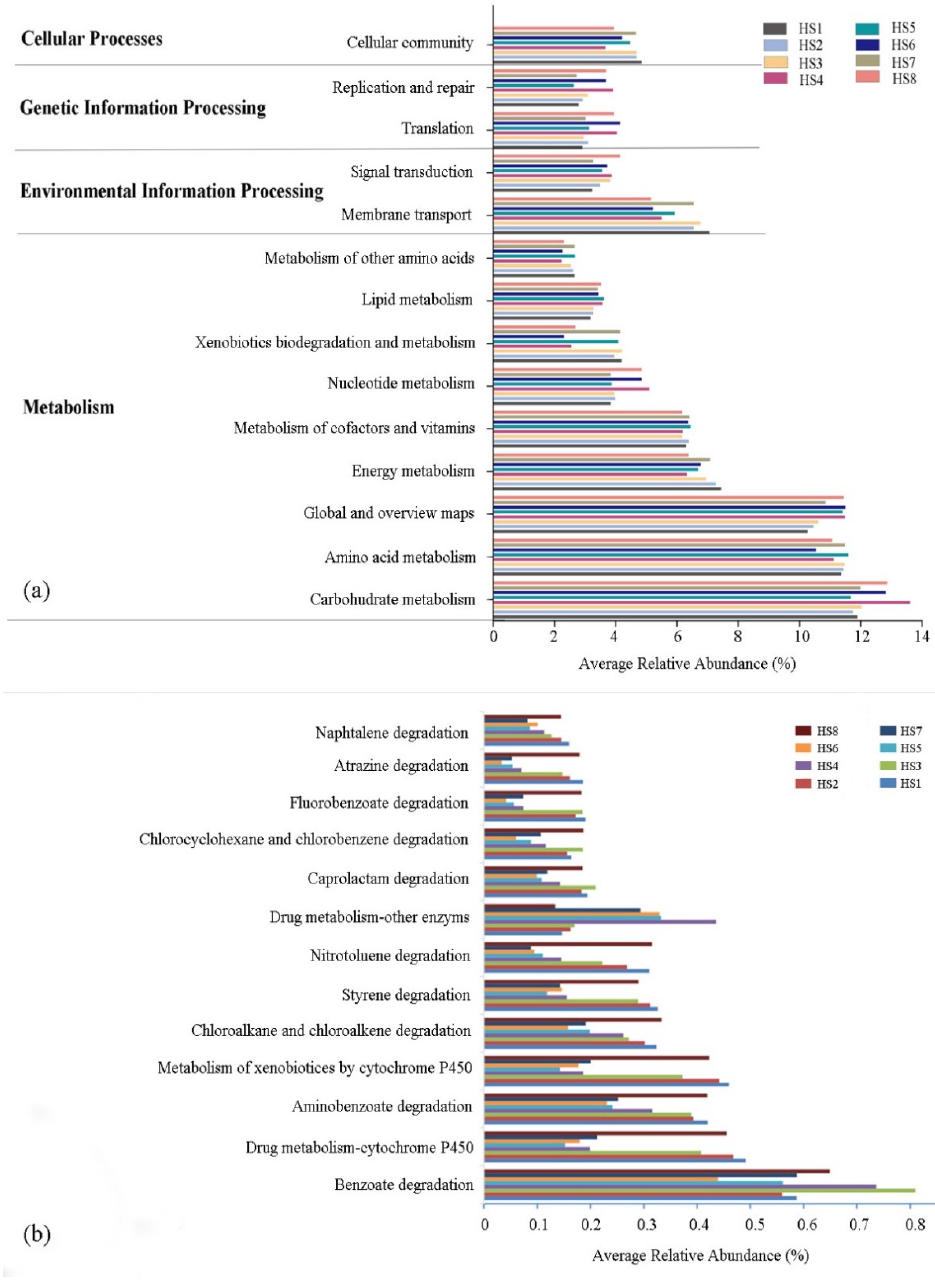
Figure 5. Functional level 1 categories (Kyoto Encyclopedia of Genes and Genomes (KEGG) ( a ))